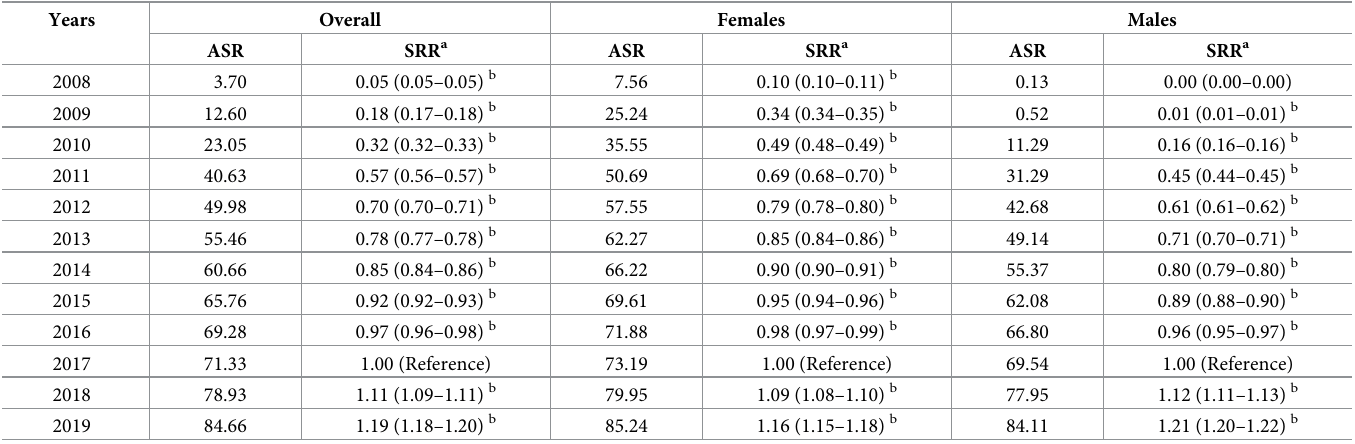
Table 1. Age-standardized rates (ASR) (per 100) and standardized rate ratio (SRR) for HPV vaccine initiation among adolescents 11–17 years old in Puerto Rico (2008–2019).